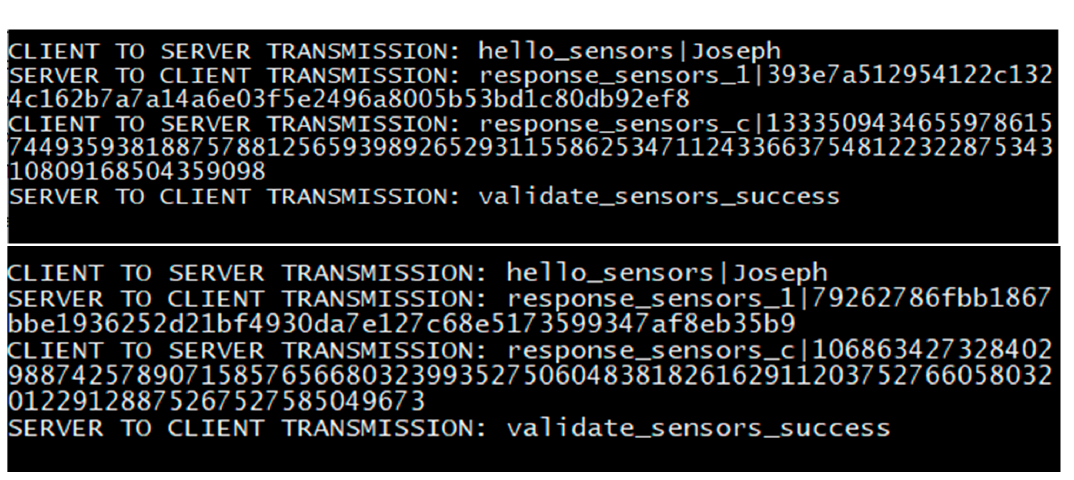
Figure 14. Intercepted data from client and server using the TFHVA scheme, between two different Figure 14. sessions.